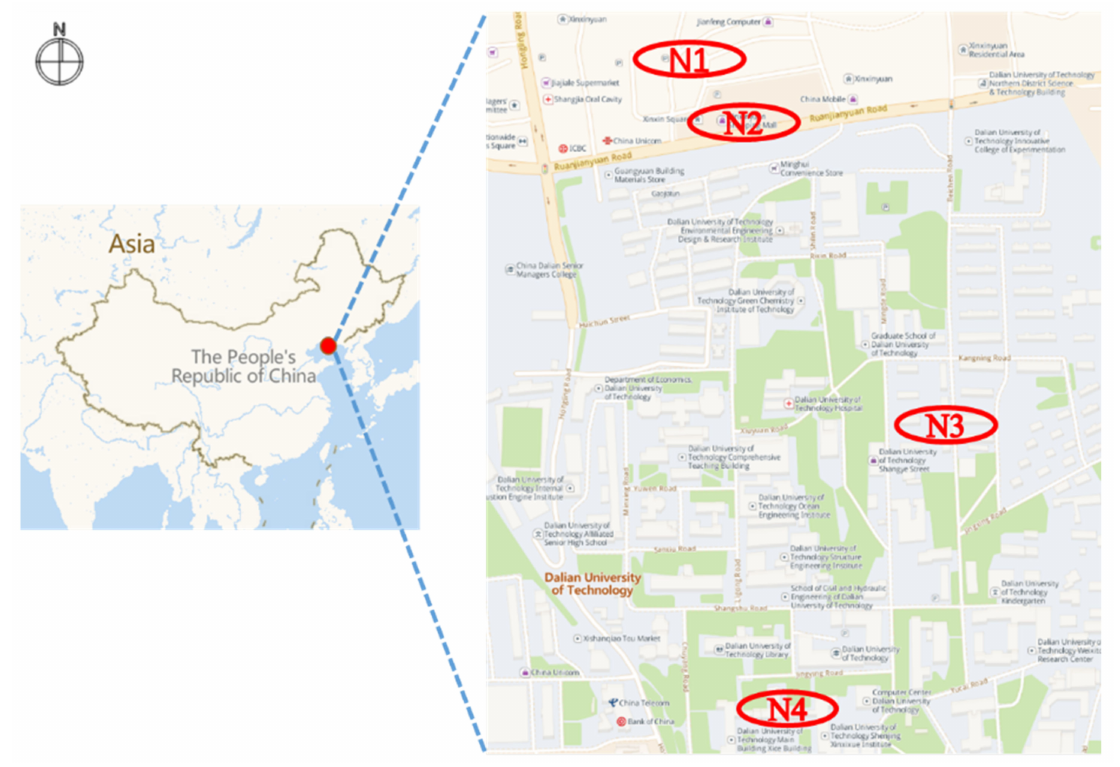
Figure 1. Geographical location of the